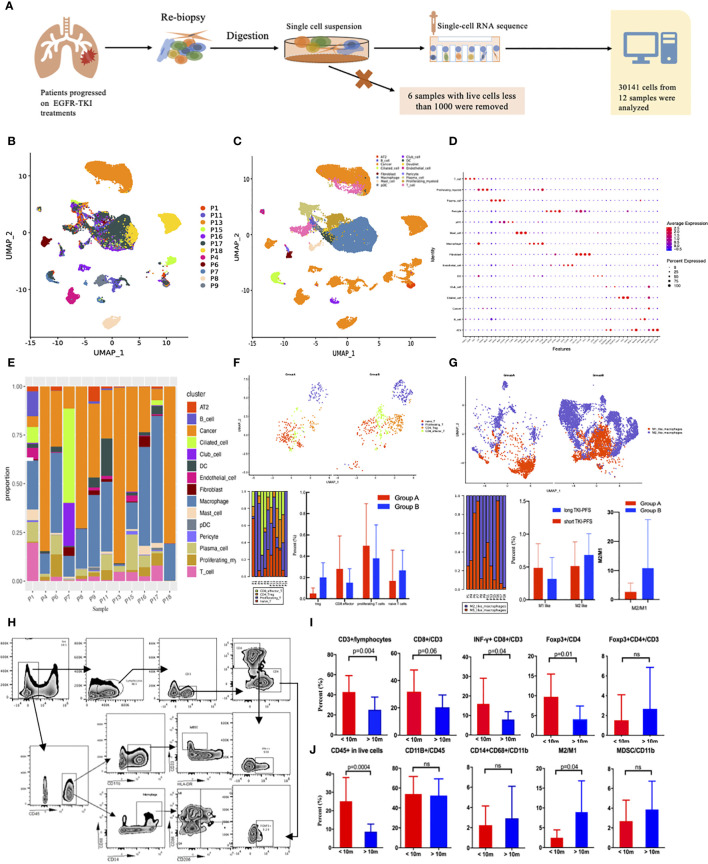
The analysis of single cell RNA sequencing and flow cytometry. (A) Flow diagram of single cell RNA sequencing; (B) Distribution of 12 samples by UMAP; (C) Distribution of 15 subtypes cells by UMAP; (D) Representative gene expression in 15 subclasses of cells; (E) Distribution of the 15 subclasses among 12 samples; (F) Subset analysis of T cells; (G) Subset analysis of macrophages; (H) the gating strategy for flow cytometry; (I, J), Box plot of flow cytometry grouped by TKI-PFS for lymphocytes and myeloid cells (TKI-PFS <10 m = 13; TKI-PFS >10 m = 13). ns, none sense.